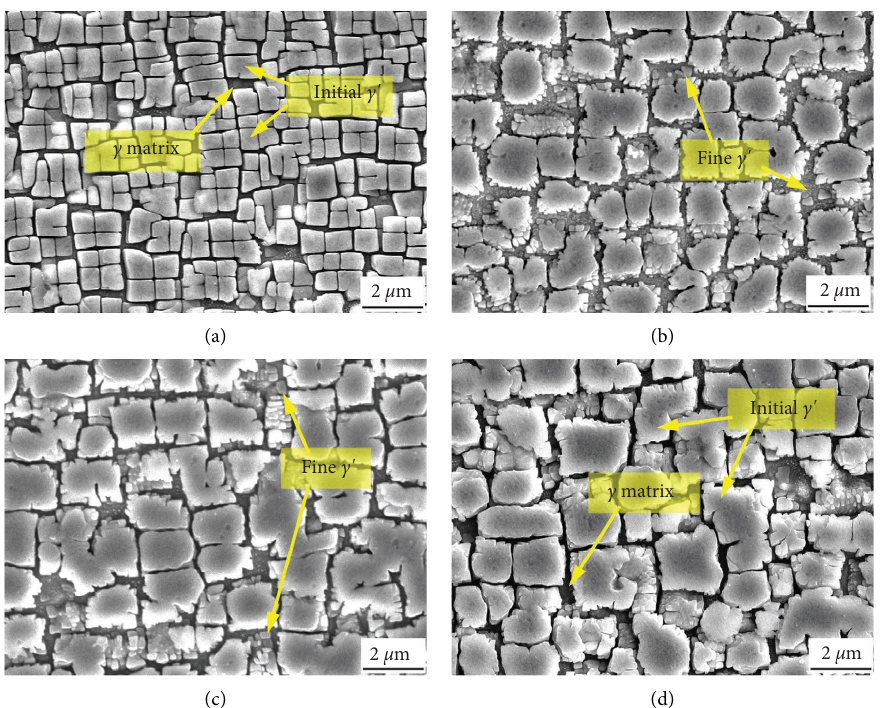
Figure 6: Comparison of c ′ precipitates in as-cast (a), HIP1175 (b), HIP1185 (c), and HIP1195 (d) dendrite cores of the K417G